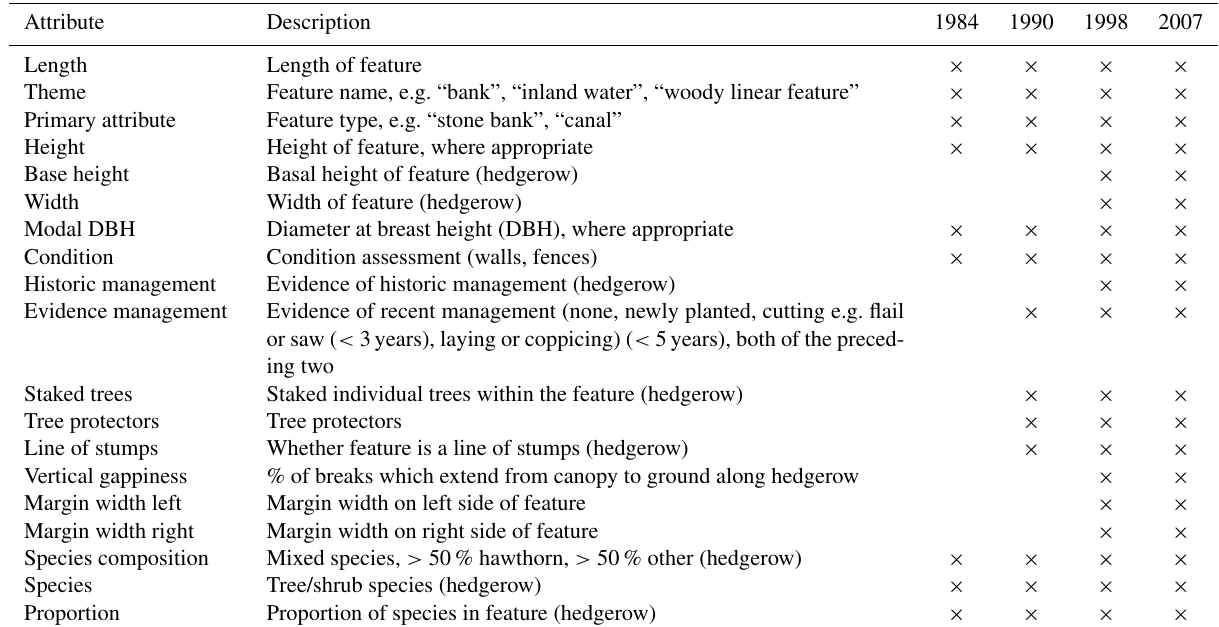
Table 3. Data collected regarding point